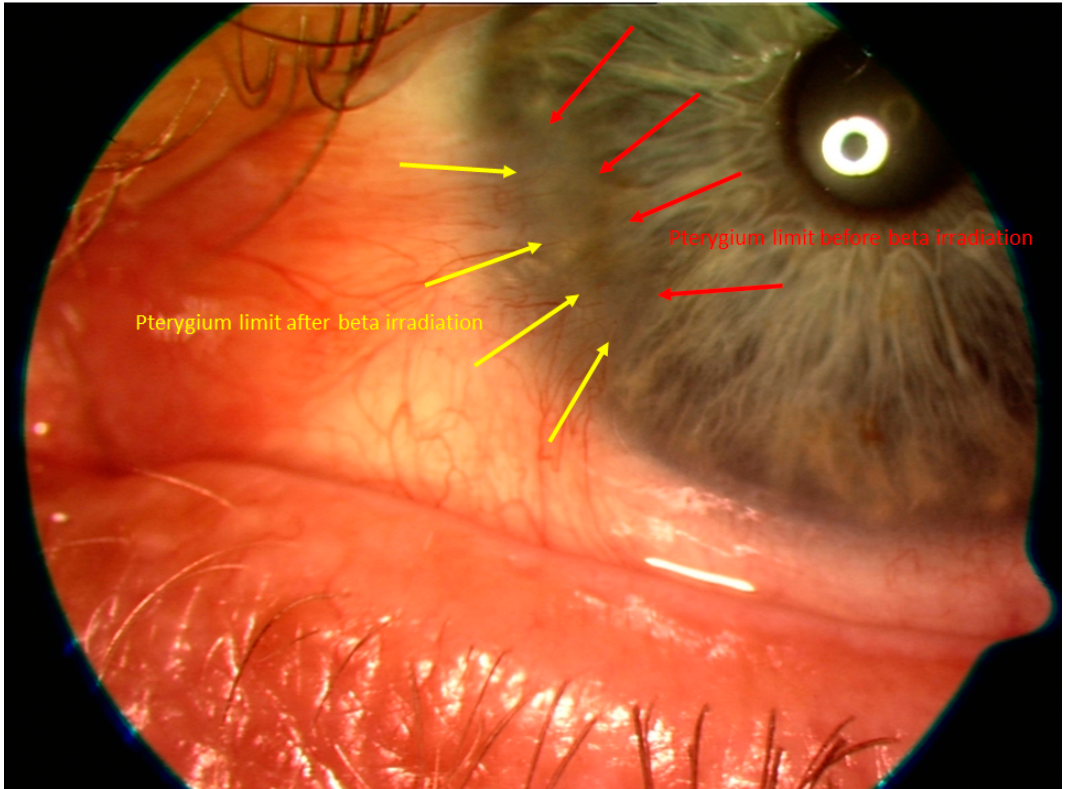
Figure 9. Shown is the regression of the pterygium after Sr-/Ytt-90 beta irradiation. The red arrows indicate where the border of the pterygium was before irradiation and the yellow arrows mark the border 12 months after irradiation.